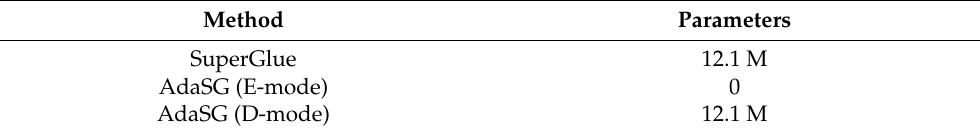
Table 1. Parameter of SuperGlue and AdaSG.